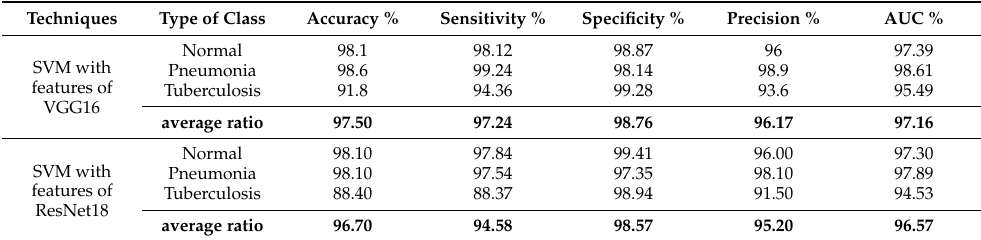
Table 3. Results of the CNN with the SVM technique for diagnosing the pneumonia and tuberculosis data set and distinguishing between them.